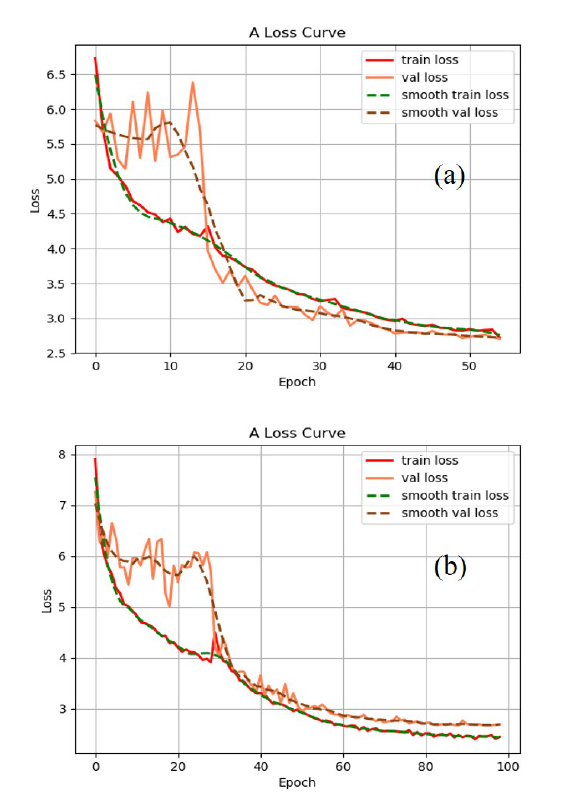
Fig. 12. Comparison of loss function based on YOLOX algorithm. (a) Loss function before improvement. (b)